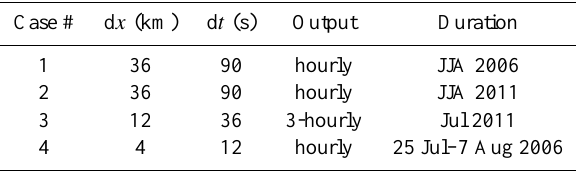
Table 1. WRF simulations performed in this